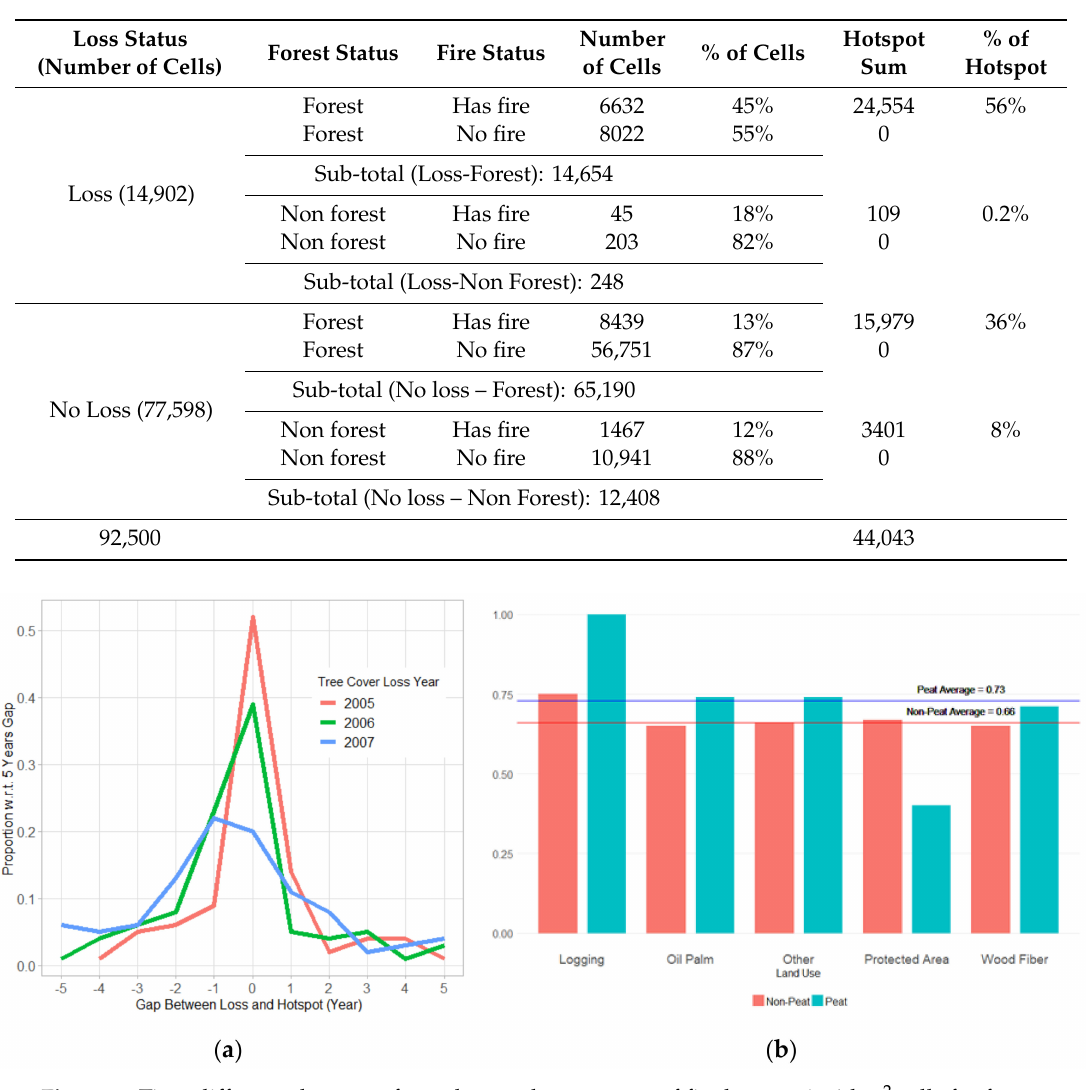
Figure 9. Time di ff erence between forest loss and occurrence of fire hotspot in 1 km 2 cells for forest loss occurring between 2005 and 2007. ( a ) Number of years between forest loss and the year with the maximum number of fire hotspots; ( b ) The fraction of cells where year with maximum number of hotspots occurs within +/ − 1 year of forest